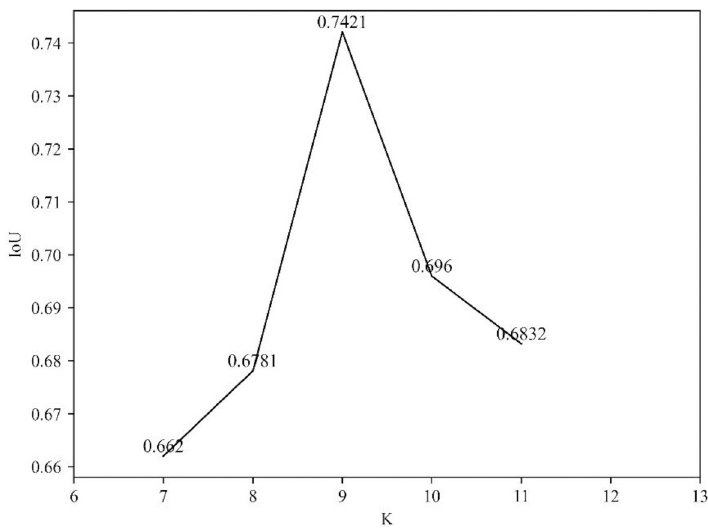
Fig 11. The IoU values obtained by K -means based segmentation model for different K .